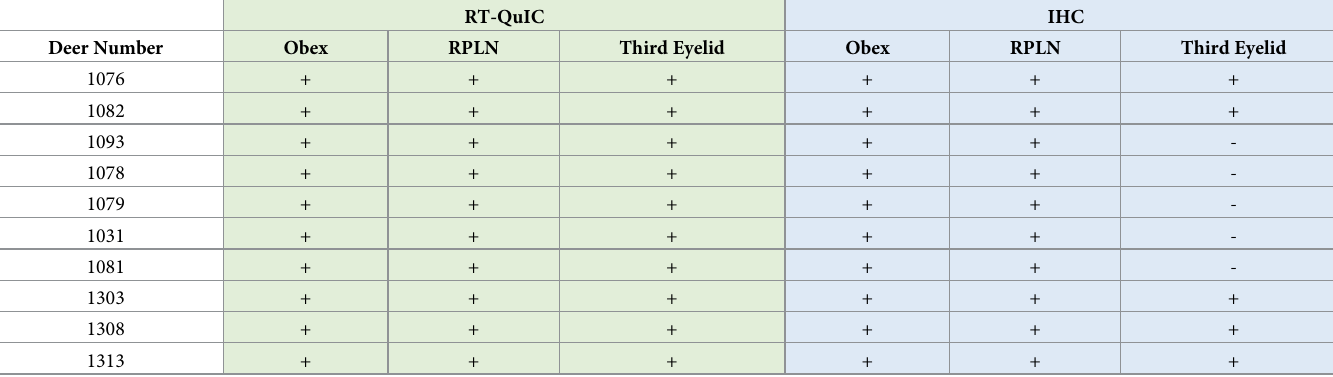
detected positivity in more third eyelid samples, 10 of 10 (100%), compared with 5 of 10 (50%) by IHC. Data are presented as animals PrP CWD positive or negative